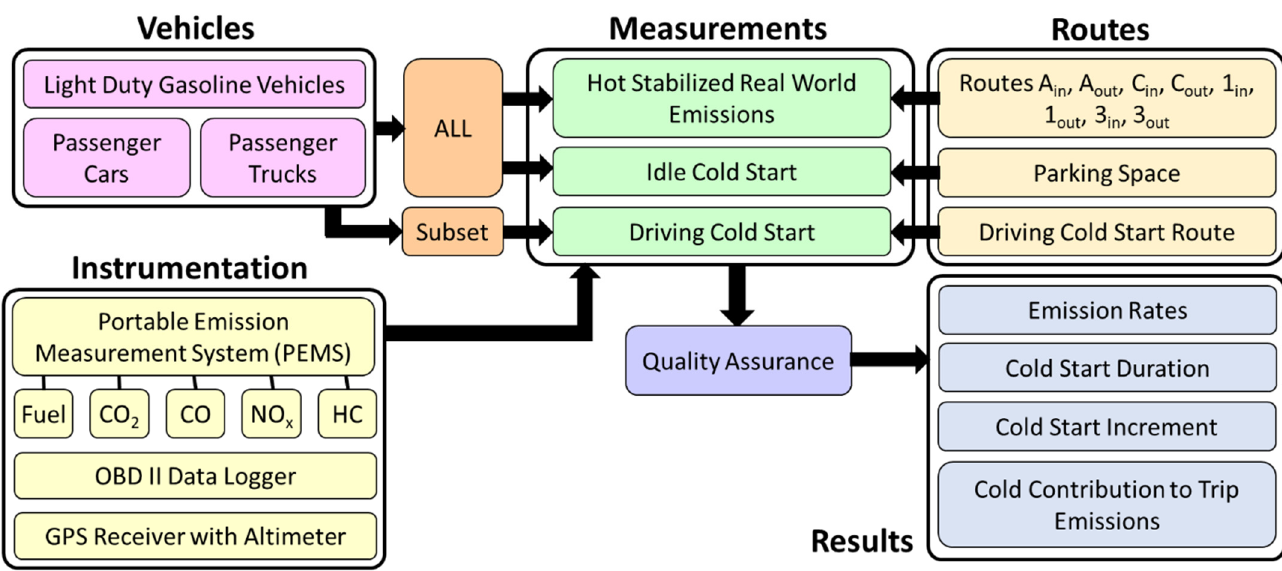
Figure 1. Simplified schematic diagram of the study design. The study design includes vehicles selected for measurement, instrumentation used for measurements, the types of measurements taken and the routes for which they were done, quality assurance, and results.